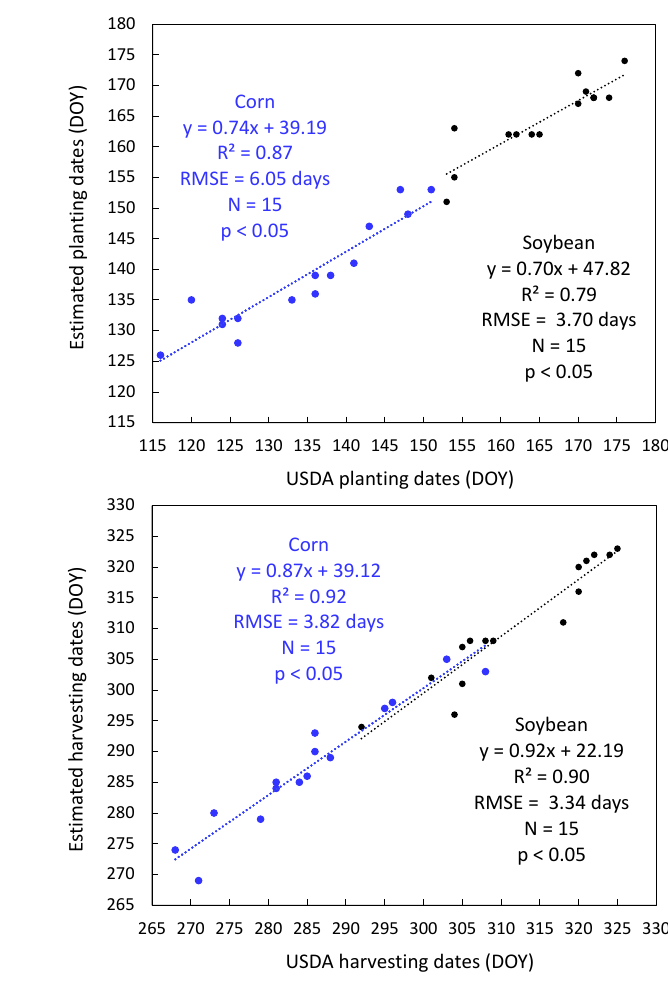
Figure 3. Evaluation of estimated crop phenology at the state level (N is 15 years, blue for corn and black for soybean; ( a ) planting dates; ( b ) harvesting dates). Remote Sens. 2021 , 13 , x FOR PEER REVIEW